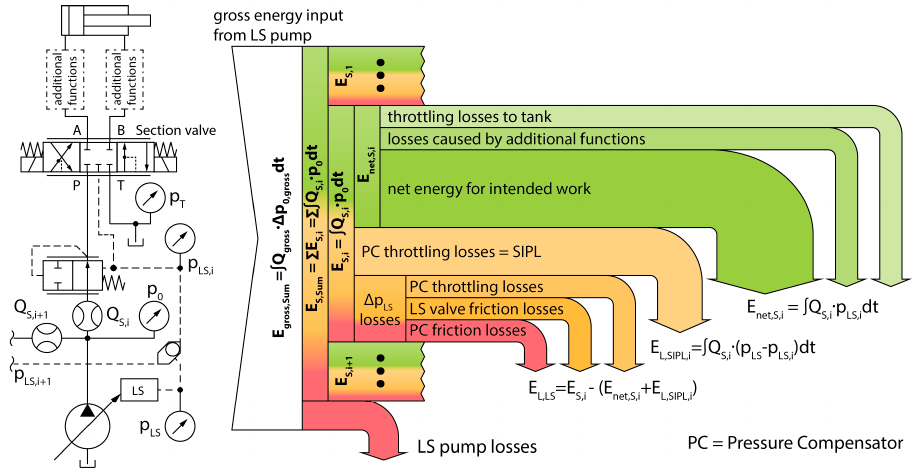
Figure 3. Energetic analysis of a hydraulic LS system, as used in the research project.